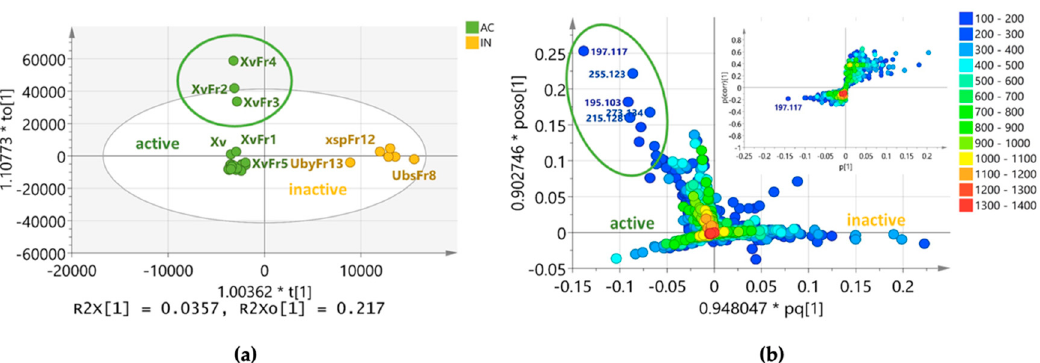
Figure 6. Multivariate analyses of 36 lichen and ELF crude extracts and selected fractions to predict the antibacterial metabolites in the Xylaria samples (Xsp and Xv). ( a ) Orthogonal projection to latent structures discriminant analysis (OPLS-DA) score scatter plot of samples categorized according to their bioactivities. ( b ) OPLS-DA loadings and S-plots with encircled features represent the bioactive metabolites of the most active samples. Active metabolites are on the left quadrants while inactive features are on the right quadrants. The pq and poso vectors indicate 94.80% and 90.27% influence of individual X- and Y-variables, respectively, to the model suggesting good prediction of underlying patterns in the data.